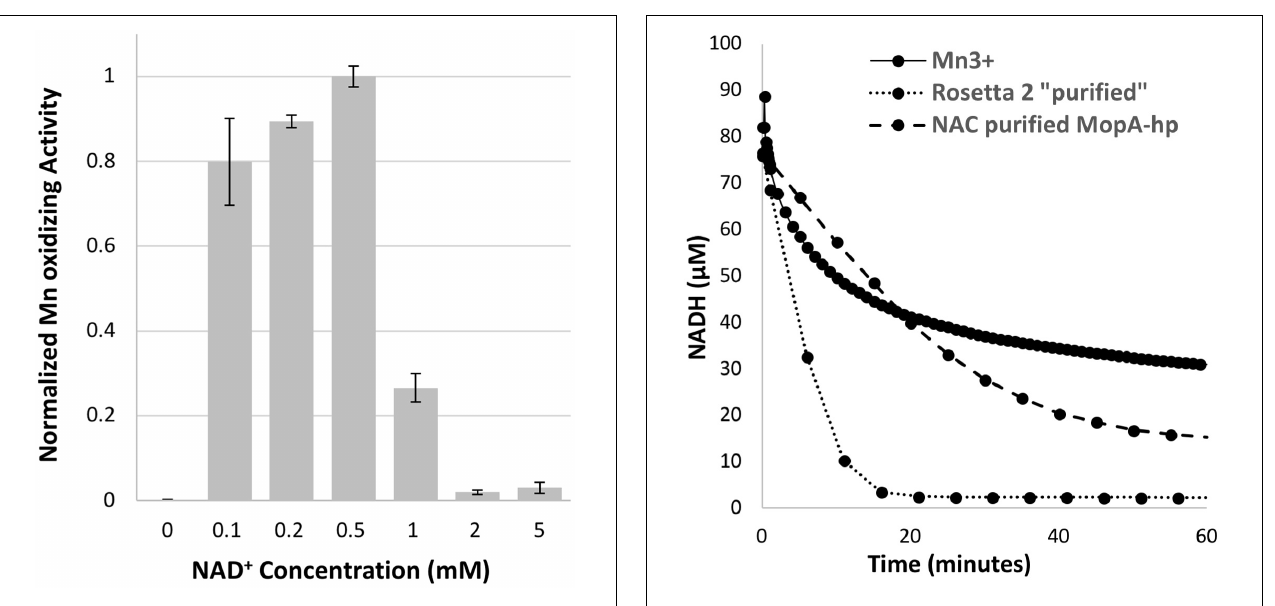
FIGURE 3 | Mn oxidizing activity is dependent upon NAD + concentration. Activity normalized to 0.5 mM NAD + concentration. Error bars represent ± one standard deviation of Mn oxidation assays run in triplicates.